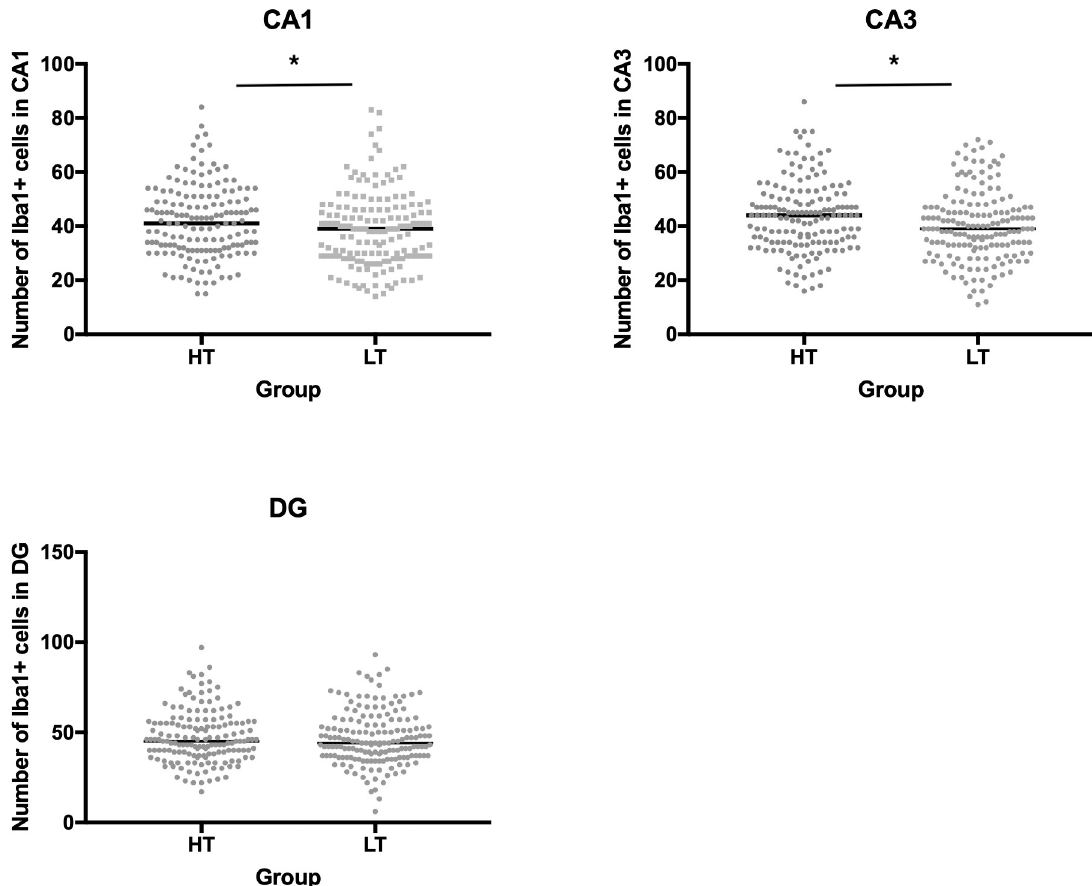
Fig 7. Interstrain differences in the number of Iba1+ cells in different hippocampal areas. The number of Iba1+ cells in the CA1, CA3 and DG areas of the hippocampus; n = 5–12 per group; bars represent medians; � p � 0,05 Mann-Whitney U test.